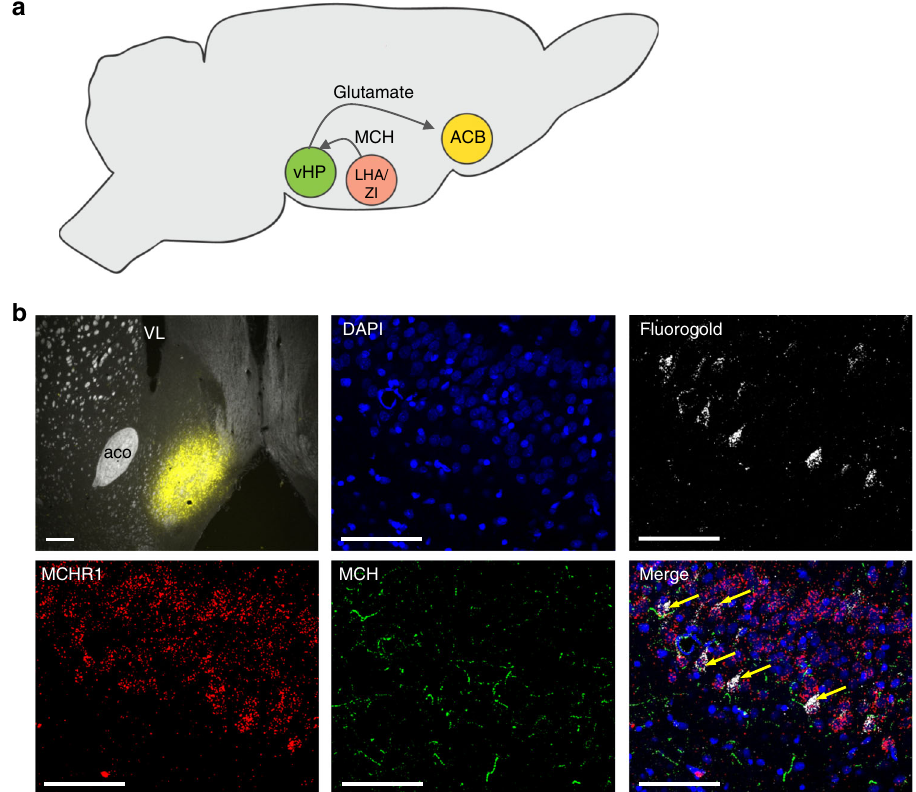
Fig. 7 The ACB is a target for vHP-projecting MCH neurons. a A cartoon schematic showing the projection pathway from MCH neurons in the lateral hypothalamus/zona incerta (LHA/ZI) to the vHP and then to the ACB. b (top left) Injection site for fl uorogold in the ACB in a 30- µ m coronal section taken from a rat brain at 1.1 mm anterior to bregma; scale = 200 µ m. Retrogradely labeled cells are shown in the CA1 subregion of the vHP in a 30- µ m coronal section taken from a rat brain at 4.7 mm posterior to bregma. DAPI nuclear counterstain is shown in blue, retrogradely labeled fl uorogold-positive cells are shown in white. Fluorescence in situ hybridization for the MCHR1 is shown in red and immuno fl uorescence staining for MCH is in green. Arrows point to MCH fi ber appositions to MCHR1-positive cells containing fl uorogold, indicating that these vHP neurons both receive input from MCH neurons and project to the ACB. Images taken at ×20 magni fi cation; scale = 50 µ m. ACB nucleus accumbens, aco anterior commissure, LHA lateral hypothalamus, vHP